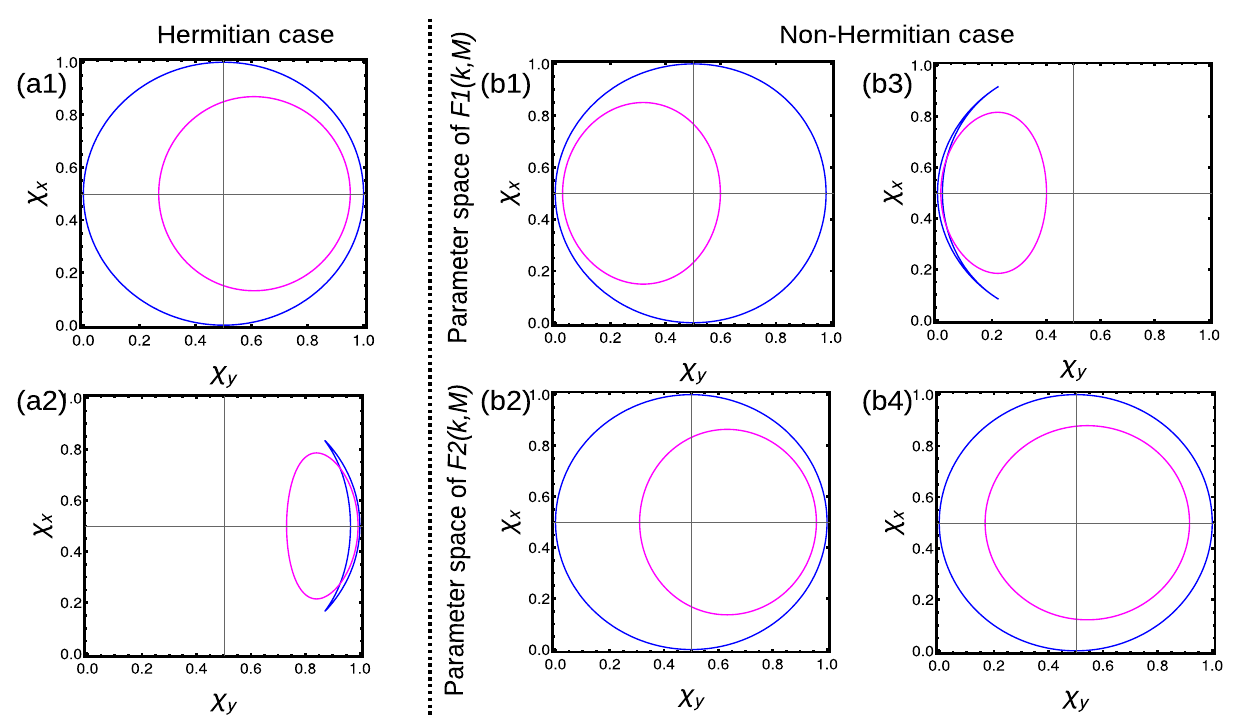
Figure 3. (Color online) Winding vector analysis of Hermitian and non-Hermitian short-range SSH chain with one neighbor coupling. The blue curve and magenta curves represent the zero temperature and T calculated using Eqs. (18) and (19) (Hermitian) and Eqs. (20) and (22) (non-Hermitian) respectively. ( a1 , a2 ) 1 and W 0 case. ( b1 – b4 ) Non-Hermitian condition with W Hermitian case with W = =